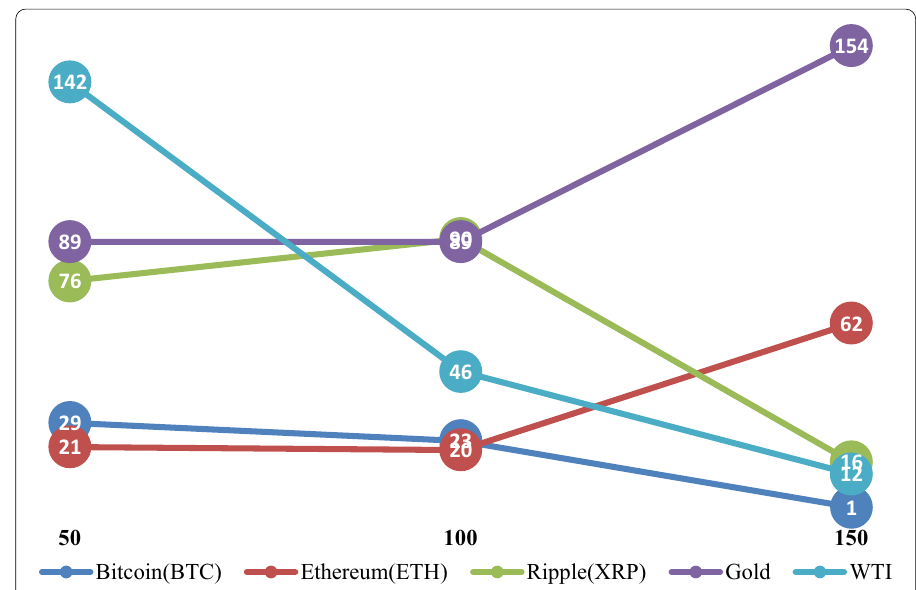
Fig. 1 Analyzing the behavior of market efficiency by AQ tests statistics at 5 percent significant level